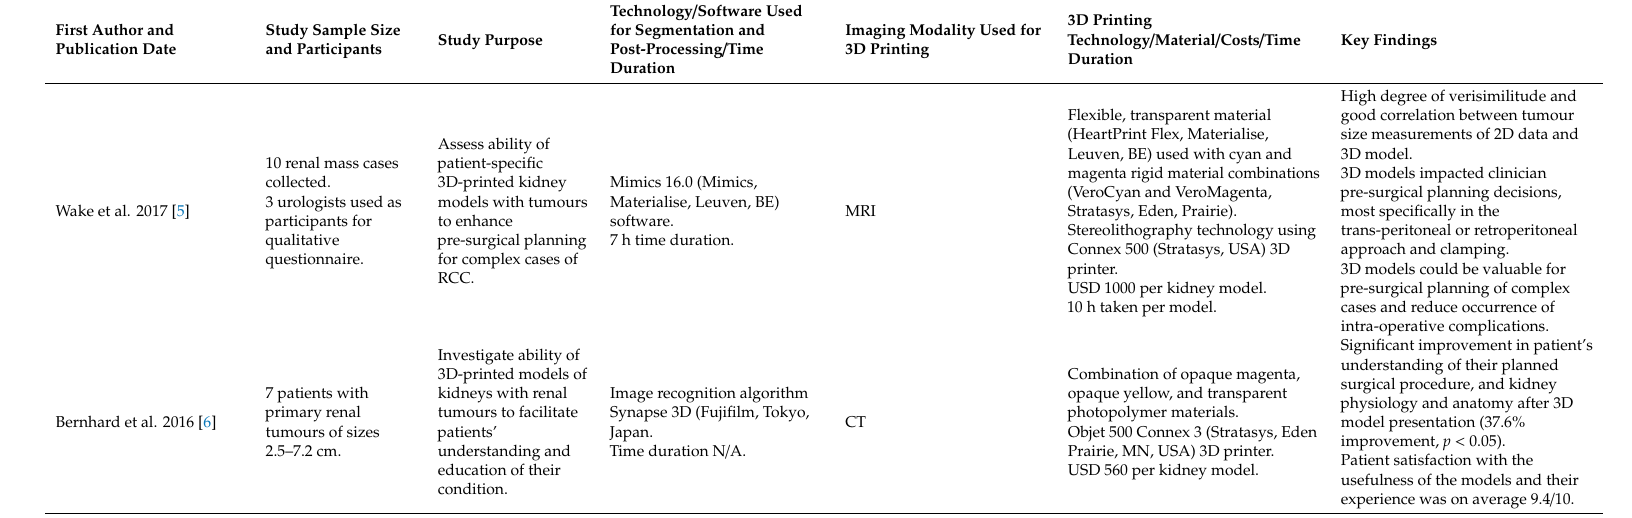
Table 1. Summary of findings of these 27 studies that were